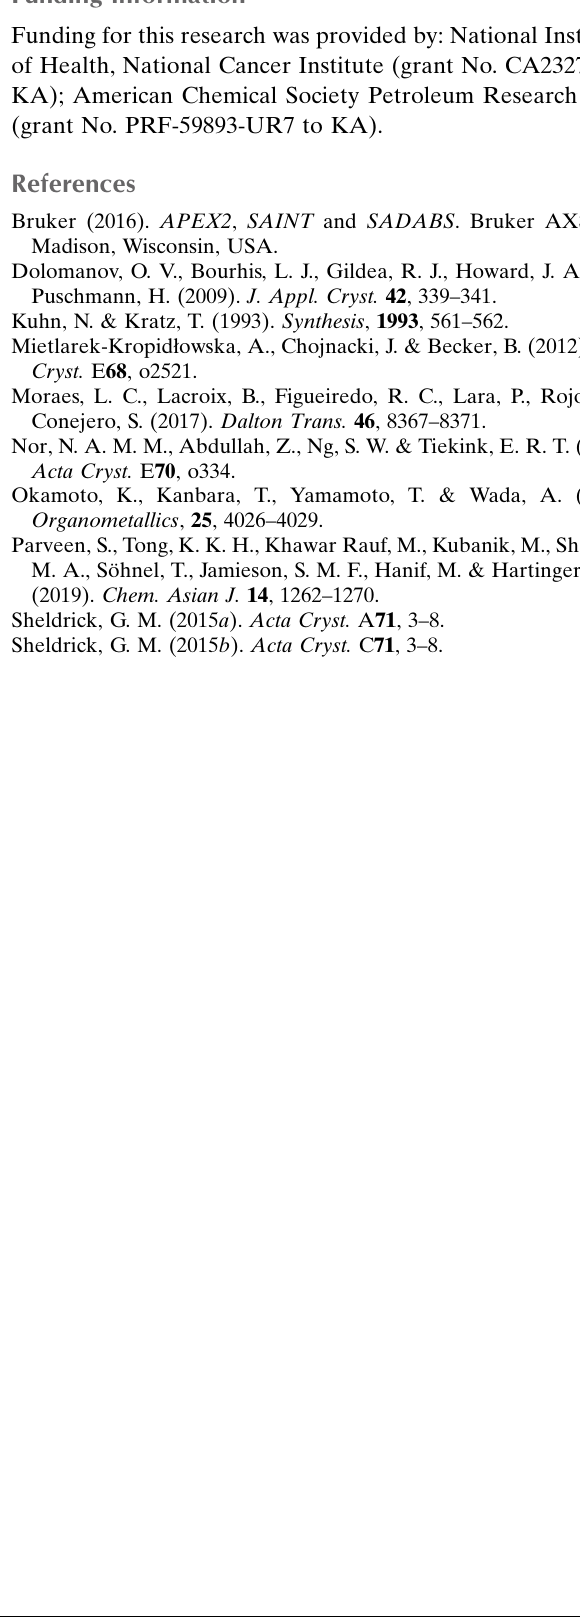
Table 1 Experimental details. Crystal data Chemical